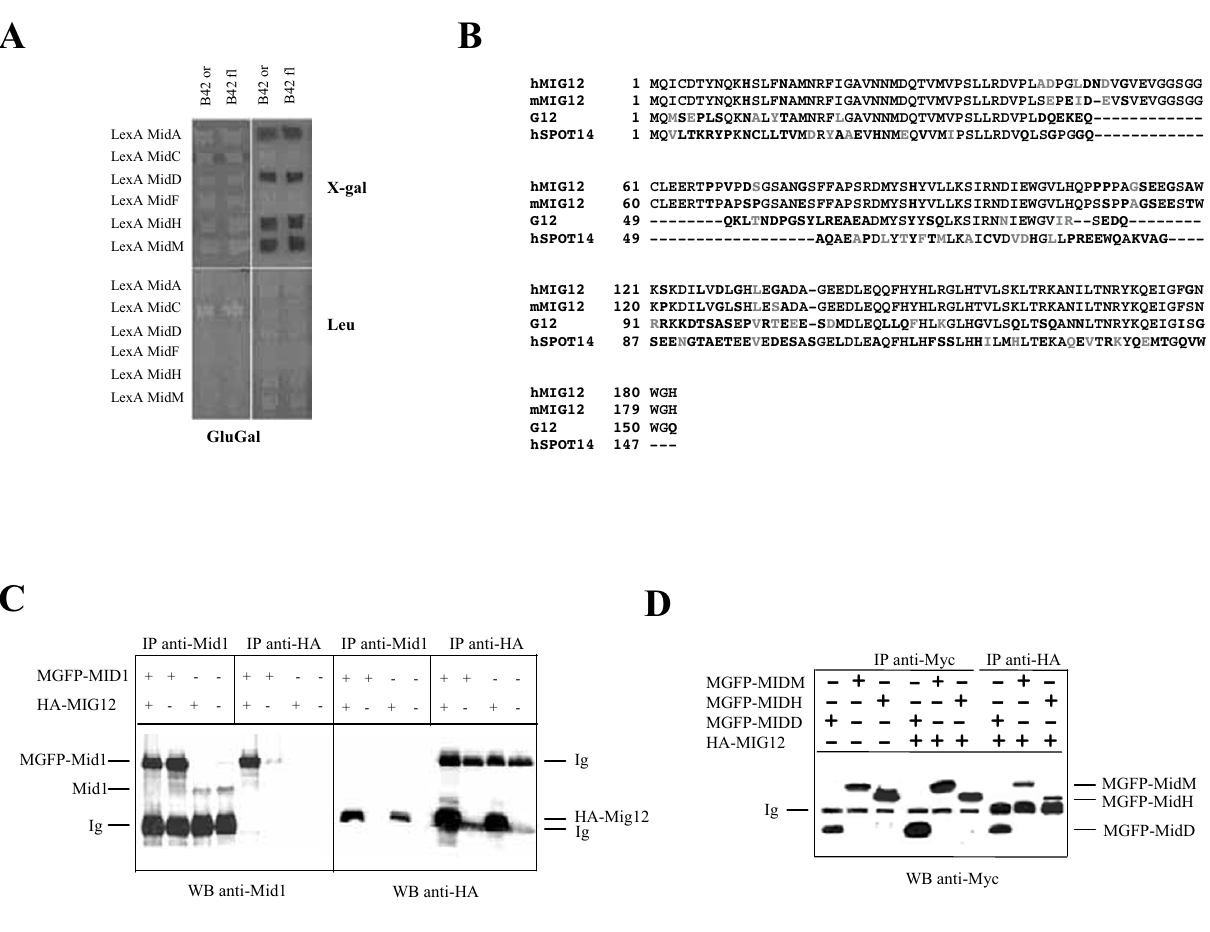
Figure 1 Identification of a novel Mid1 partner. ( A ) Interaction-mating assay that confirms Mid1-Mig12 interaction in yeast. B42 fl, Mig12 full-length fused to the B42 activation domain; B42 or, the largest original Mig12 clone fused to the B42 activation domain; LexA Mid, constructs encompassing different MID1 domains fused to the LexA DNA binding domain: A, full-length; C, BB; D, CC; F, RFP-like; H, R-BB-CC; M, CC-FNIII-RFP-like. Both the full-length and the original Mig12 clones specifically interact with the entire Mid1 protein and with some of its truncated mutants, MidD, MidH and MidM, as shown by yeast turning blue on X- gal plates and growing on plates lacking leucine (Leu), only when galactose (Gal), and not glucose (Glu), is used as carbon source. Abbreviations: BB, B-box1 and B-box2 domains; CC, coiled-coil domain; FNIII, fibronectin type III repeat; R, RING domain. ( B ) Amino acid sequence of human (h) and mouse (m) MIG12 and comparison with the zebrafish G12 and the human SPOT14 proteins. Amino acids that are identical at least in the human and murine Mig12 are in bold. Conserved amino acids are indicated in gray. The human and mouse MIG12 share 90% of similarity and 88% of identity. The hMIG12 and the zebrafish protein share 56% of similarity and 46% of identity, whereas the homology with the human SPOT-14 protein is 49% and 31%, respectively. There is a gap of 25 aa that are not present in the zebrafish and SPOT14 proteins. ( C ) Co-immunoprecipitation experiments showing Mid1-Mig12 interaction. Western blot (WB) analysis using anti-Mid1 and anti-HA antibodies after immu- noprecipitation of HEK293 cells transiently transfected with different combination of MycGFP-tagged Mid1 (MGFP-MID1) and an HA-tagged Mig12 (HA-MIG12); + and - indicate the constructs transfected in each lane. The antibodies used for the immu- noprecipitations (IP) are indicated. Mid1 indicates the band corresponding to the endogenous protein. Ig, immunoglobulins. In some experiments, we detected a trace amount of MGFP-Mid1 immunoreactivity in cells transformed with only MGFP-Mid1 and immunoprecipitated with the anti-HA antibody. This signal was always much less than that seen when both tagged con- structs were transfected together. ( D ) The same as in (C) using the MGFP-MidM, MGFP-MidH and MGFP-MidD mutant fusions, instead of the full-length protein, in the co-transfections and an anti-Myc antibody for Western blot